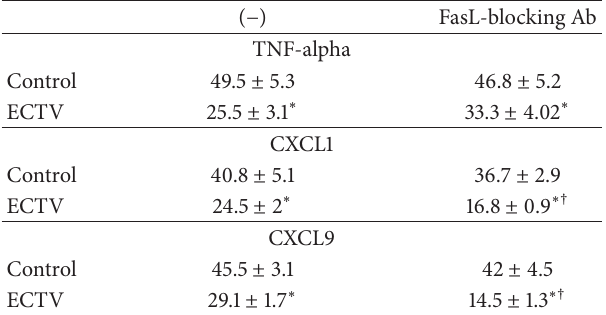
Table 1: Production of TNF-alpha, CXCL1, and CXCL9 in pg/mL in the supernatant of epithelial Hepa 1–6 cells and bone marrow derived macrophages (BMMF) cocultures infected or not with ECTV for 24 h and incubated or not in the presence of 10 𝜇 g/mL of anti-FasL-blocking antibody (clone MFL-4). All results represent means from 3 separate experiments ±